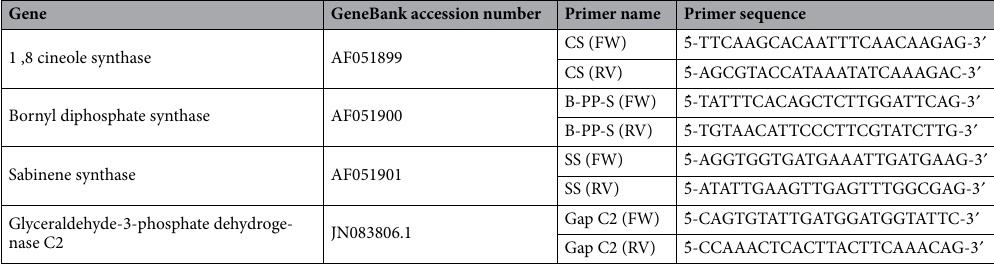
Table 1. Description of reference genes and the monoterpene synthase primer sequences for